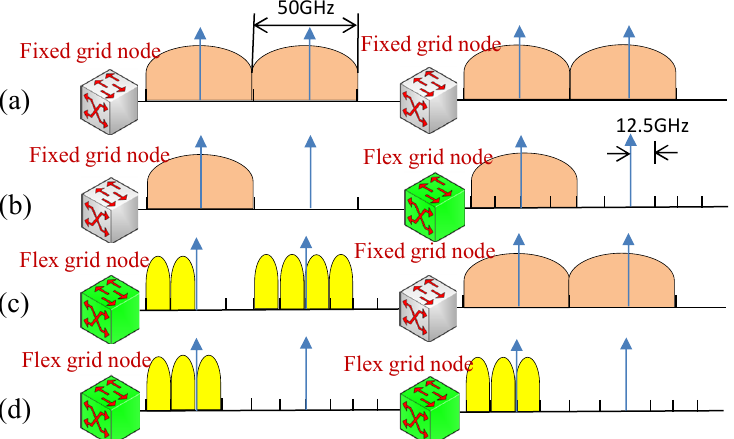
Figure 2. Spectrum assignment cases in mixed-fixed/flexible-grid optical infrastructures: ( a ) origin from fixed grid node and pass fixed grid node; ( b ) origin from fixed grid node and pass flex grid node; ( c ) origin from flex grid node and pass fixed grid node; ( d ) origin from flex grid node and pass flex grid node.